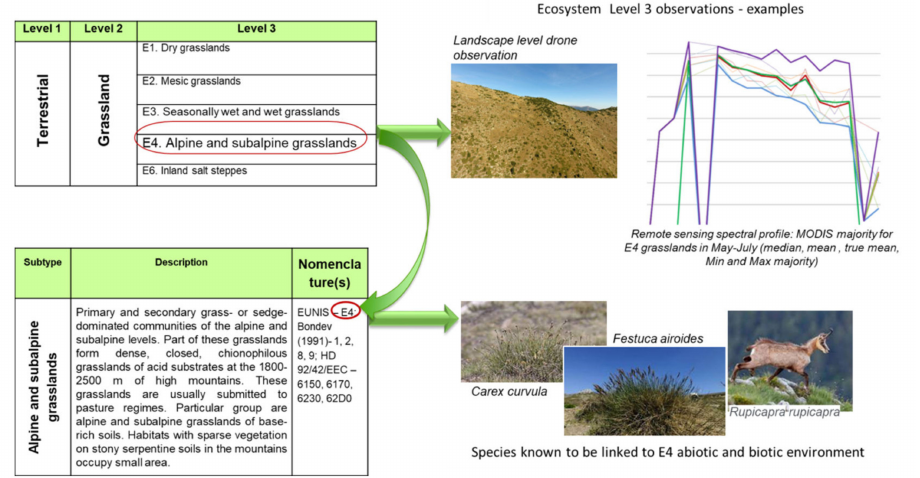
Figure 3. Crosswalk links between different hierarchies of the Whole System and different observa- tions at the appropriate scale: Above—system level; below—species and populations